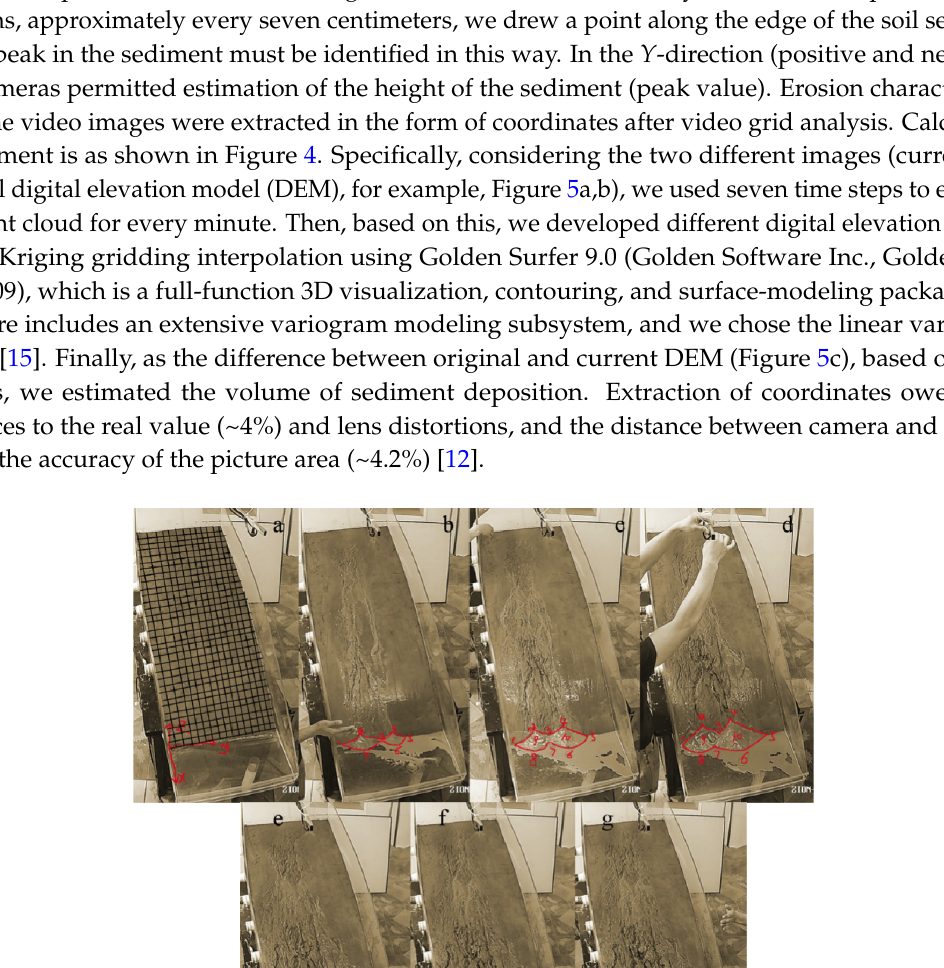
Figure4. The principle of sediment volume calculation. The red area is the initial slope part and the blue area is the sediment volume.